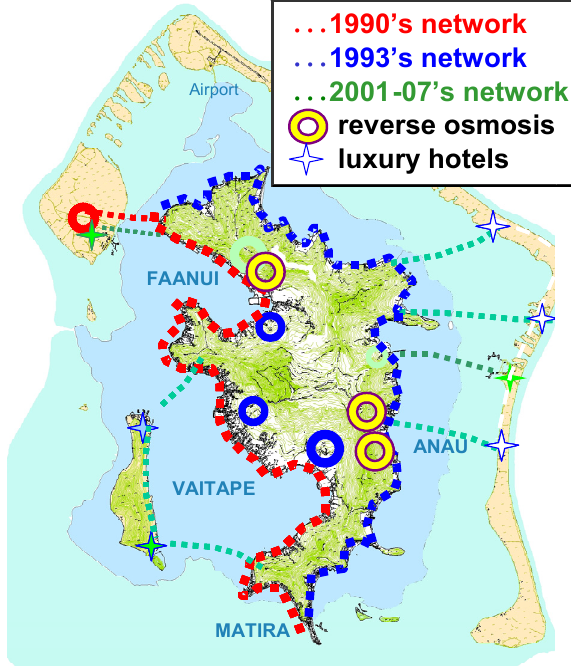
Figure 2. Main stages of development of water production and